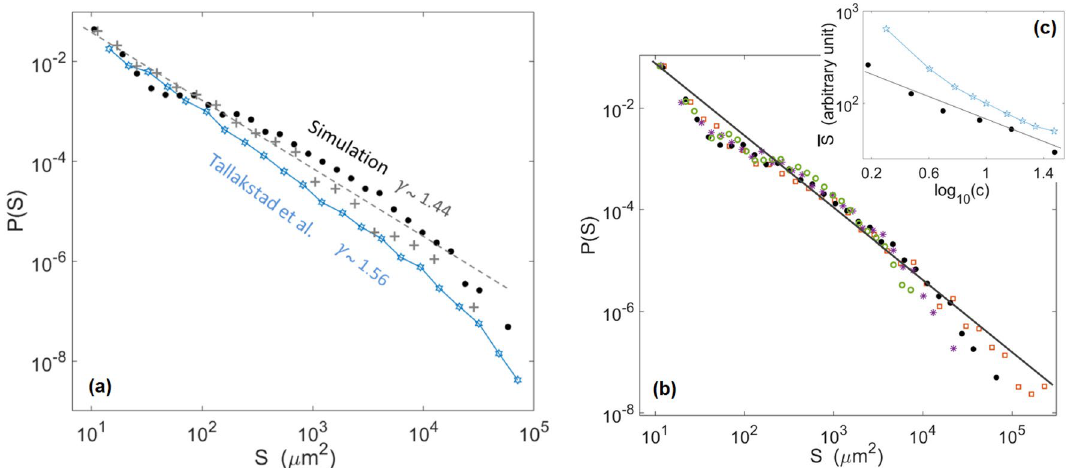
Figure 8. ( a ) Probability density function of the surface of the modelled avalanche clusters (plain points) and of the modelled pinning clusters (crosses), for a threshold c = 3 . The straight dashed line has a slope γ = 1.44 , as per Eq. (12). For comparison, the hollow stars show the experimental probability density function obtained by Tallakstad et al. 28 for the avalanche and pinning clusters (both are overlapping, see Fig. 10 of their manuscript). ( b ) Same probability density function for various c values: c = 1.5 (squares), c = 3 (plain points), c = 6 (stars), c = 12 (circles). The straight line has a slope γ = 1.4 , as per Eq. (12). ( c ) Variation of the mean avalanche size S as a function of the threshold c for the simulation (plain points) and the experiments (hollow stars). The modelled S is expressed in pixels (one pixel is 9 µ m 2 ) and the experimental S reported by Tallakstad et al. 28 (in their Fig. 13) is in an arbitrary unit, so that the magnitude of both should not here be compared. We have here shifted up this experimental data set for an easier comparison with the numerical one. The straight line has a slope 0.68.